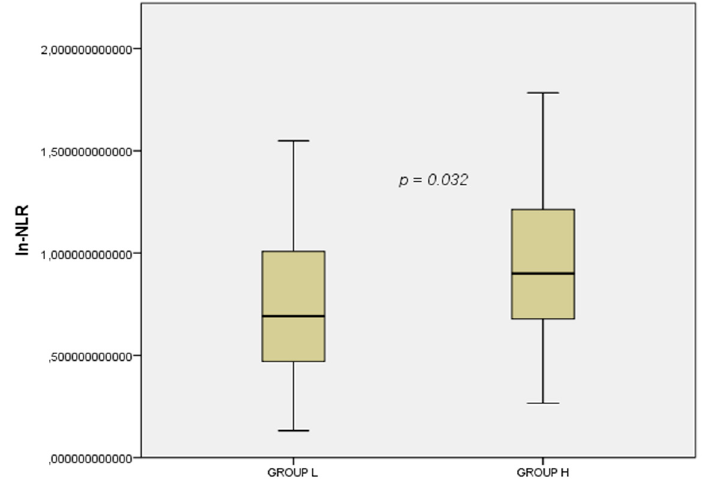
Figure 2. Box plot of the ln-NLR in the two groups. Group L, Low disease activity; Group H, High disease activity; ln.NLR, log transformation of the neutrophil to lymphocyte ratio.